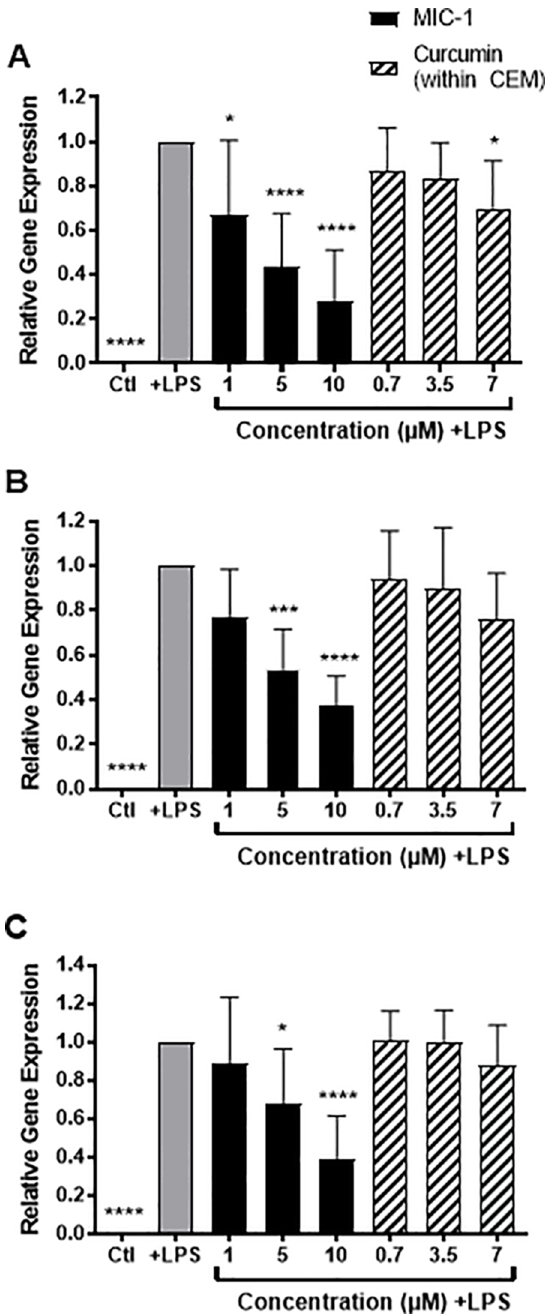
Fig 7. Effects of MIC-1 (1, 5, and 10 μ M) and CEM (curcumin concentrations of 0.7, 3.5 or 7 μ M) on LPS-stimulated pro-inflammatory gene expression in RAW 264.7 murine macrophages. Gene expressionof A) iNOS, B) IL-1 β , and C) IL-6 comparedto Ctl without LPS and +LPS control. Data are the mean ± SD of 7 independentexperiments. * P < 0.05 *** P < 0.001, **** P < 0.0001, one-wayANOVA followedby Dunnett’s post hoc test comparedto +LPS